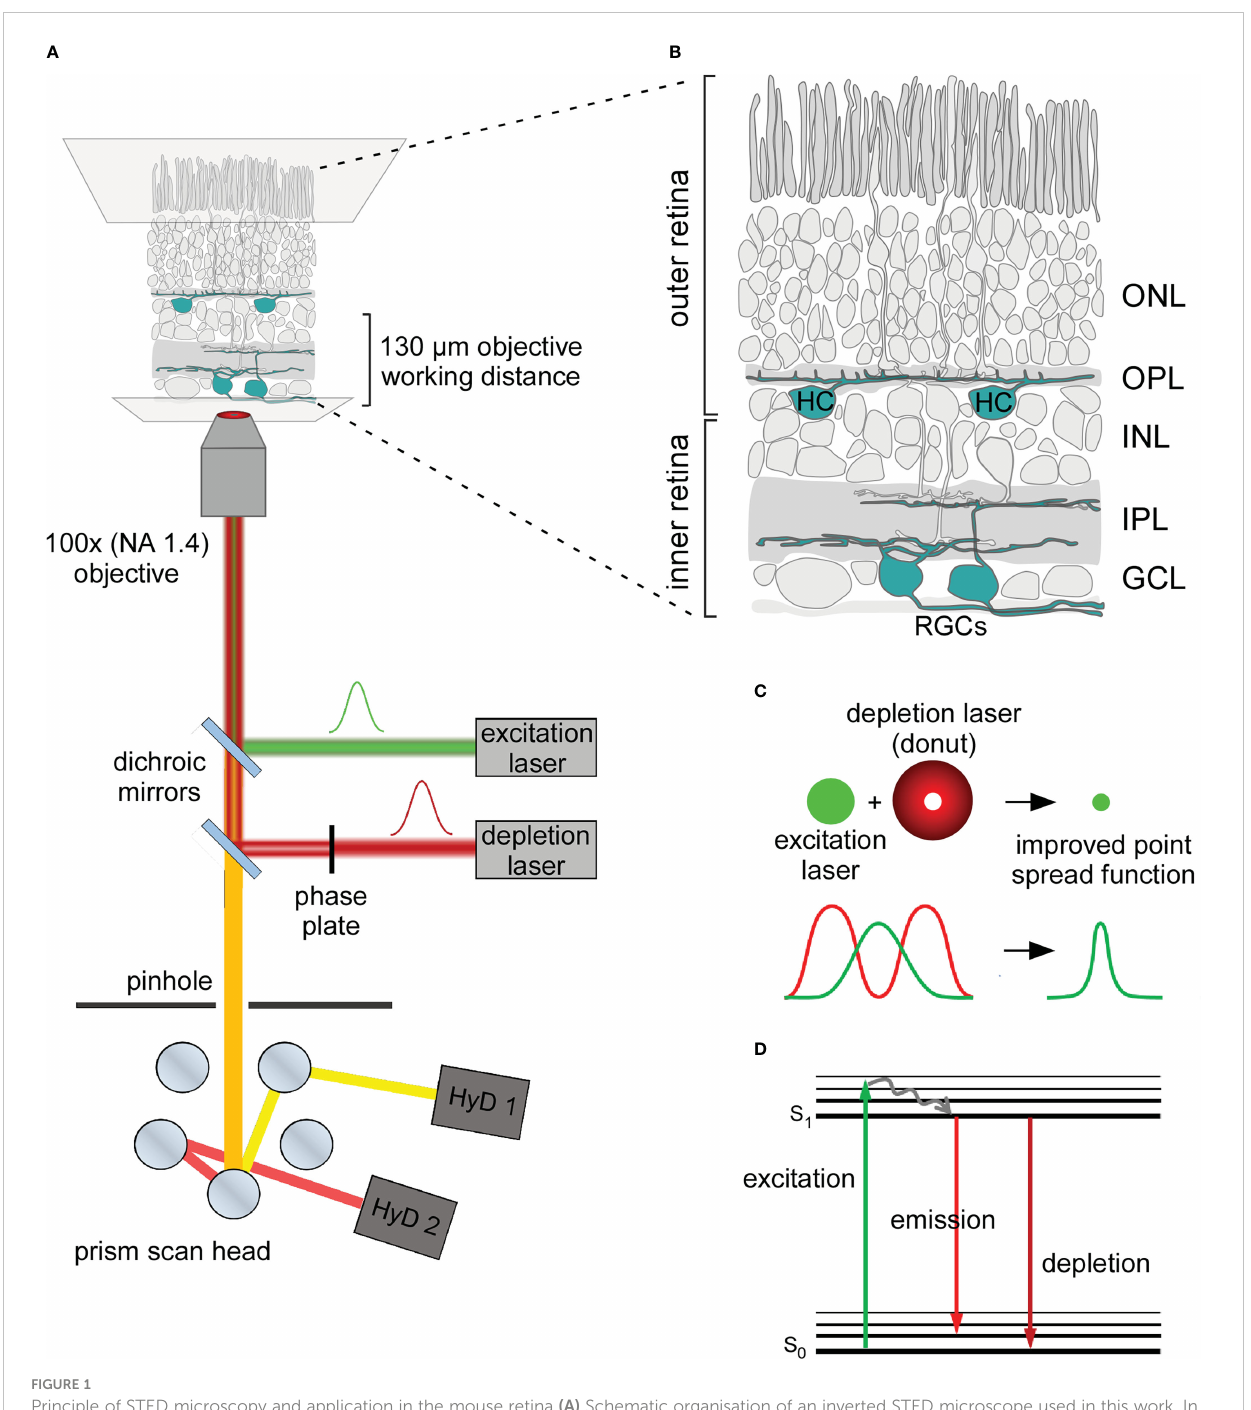
FIGURE 1 Principle of STED microscopy and application in the mouse retina (A) Schematic organisation of an inverted STED microscope used in this work. In addition to the excitation laser (green) the microscope includes a red shifted depletion laser (red) which is converted into a donut shape by passing through a gradient phase plate. Depletion and excitation lasers are aligned with dichroic mirrors and focused on the sample. Emission photons (orange) are passed back through a pinhole. Distinct emission wavelengths are separated in the prism scan head and transmitted to multiple hybrid detectors (HyDs). NA, numerical aperture. (B) Illustration of the whole-mount mouse retina for STED imaging of retinal ganglion cells (RGCs) in the inner retina and horizontal cells (HCs) in the outer retina depicted in cyan. ONL, outer nuclear layer; OPL, outer plexiform layer; INL, inner nuclear layer; IPL, inner plexiform layer; GCL, ganglion cell layer. (C) Lateral resolution is improved with STED microscopy: The donut-shaped depletion laser depletes emission from the periphery of the excited volume and reduces the effective point spread function. (D) Jablonski diagram depicting